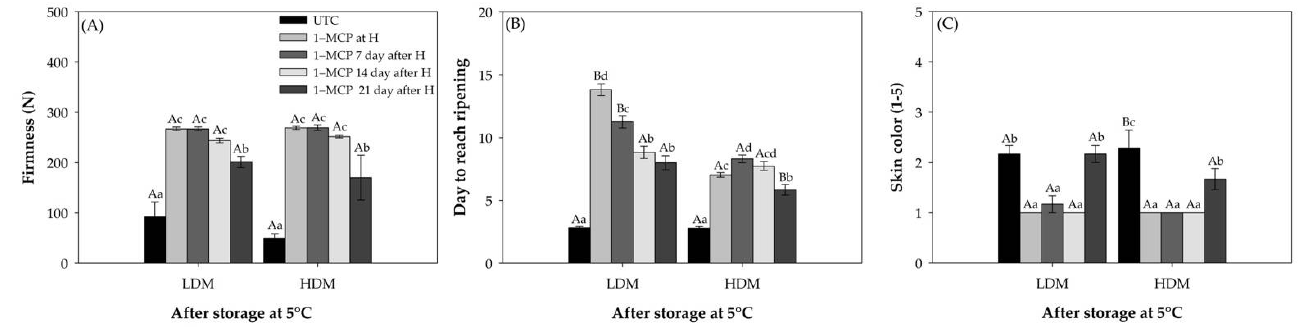
Figure 1. Quality and physiological parameters of “Hass” avocado. Untreated control (UTC, fruit without 1–MCP), application of 1–MCP at harvest, 7 d, 14 d, and >21 d after harvest, all fruit were put in cold storage (35 d at 5 °C) in regular air. ( A ) Firmness (N). ( B ) Days to reach ripening. ( C ) Skin color (range 1–5). Different lowercase and capital letters indicate a significant difference among treatments and maturity stages by LSD analysis ( p < 0.05). H: Harvest.